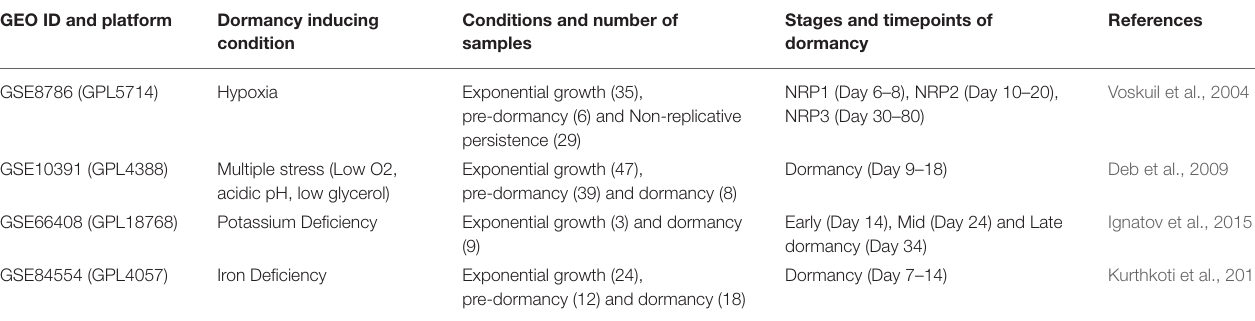
TABLE 1 | Transcriptome datasets from GEO database considered in this study for in vitro Mtb for 4 different dormancy